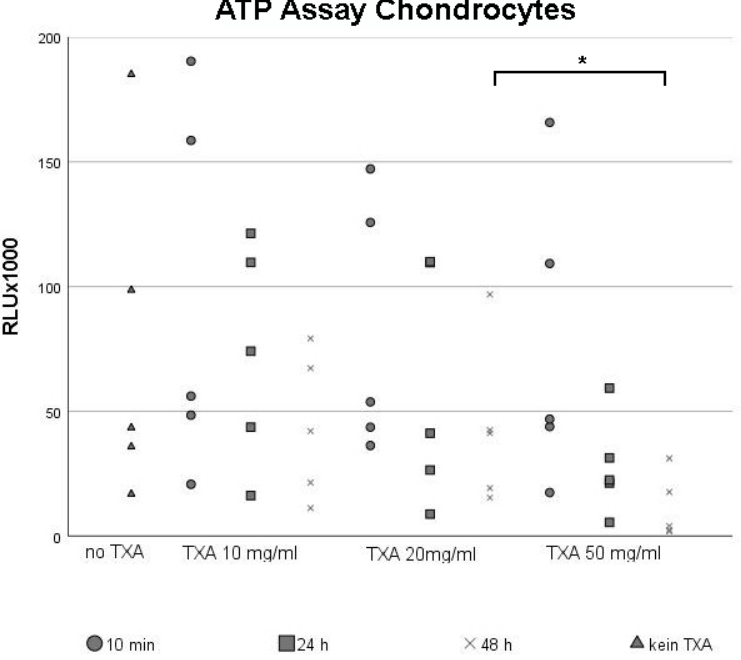
Figure 1. ATP assay of chondrocytes cultured in monolayers after treatment with 0 mg / mL, 10 mg / mL, 20 mg / mL and 50 mg / mL of tranexamic acid for varying exposure times. Chondrocytes from five di ff erent donors were seeded in cell culture flasks, incubated in cell culture medium and grown to confluency. After reaching confluency, cells were exposed to 0 mg / mL (no TXA), 10 mg / mL, 20 mg / mL or 50 mg / mL of TXA. The exposure time varied from 10 min to 24 h to 48 h. Chondrocyte proliferation was evaluated using the ATP assay. Each dot represents a single value from all five examined donor samples after treatment with di ff erent concentrations of TXA for indicated exposure times. * Significant di ff erence ( p < 0.05) compared to control samples. TXA, tranexamic acid; min, minutes; d, days; h,